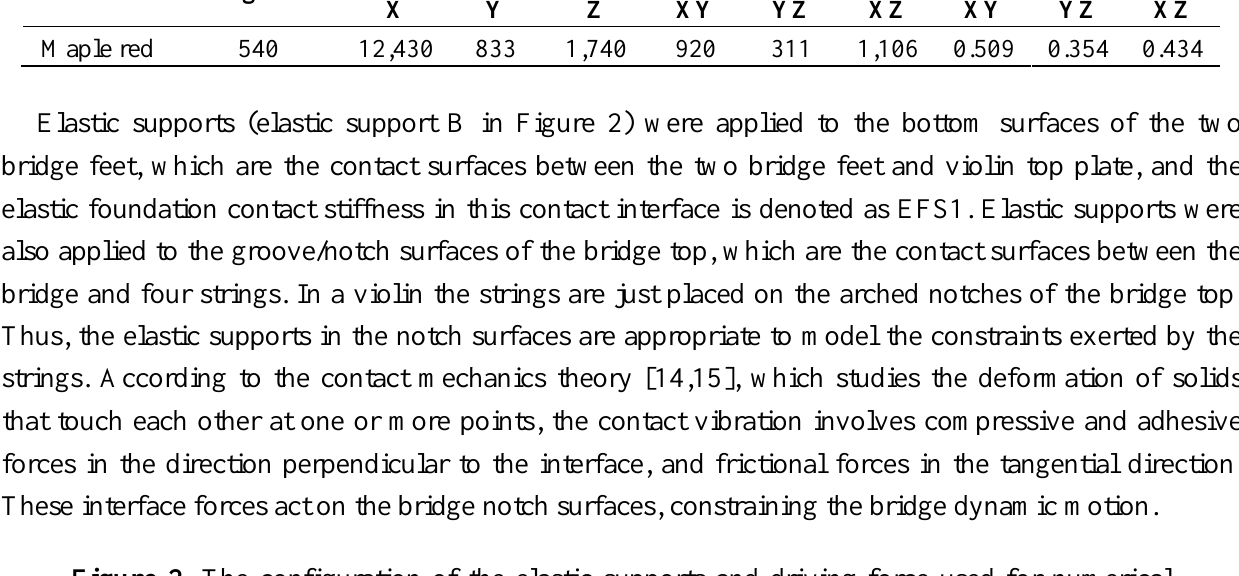
Figure 2. The configuration of the elastic supports and driving force used for numerical analysis of the bridge contact